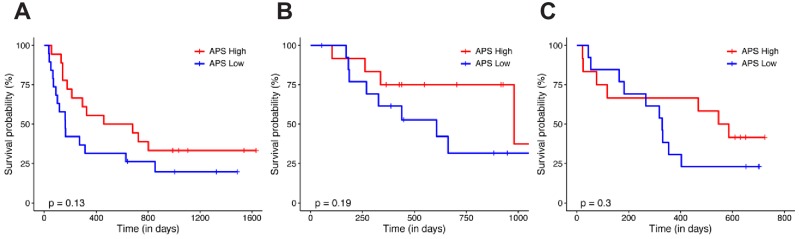
APS in predicting the clinical response to immunotherapy.Patients were grouped on the basis of APS status. The Kaplan–Meier (KM) overall survival curves were compared between APS-High and APS-Low in the Van Allen et al. (2015) melanoma dataset (A), in the Hugo et al. (2016) melanoma dataset (B), and in the Snyder et al. (2017) urothelial cancer dataset (C). Log-rank test p-values are shown.